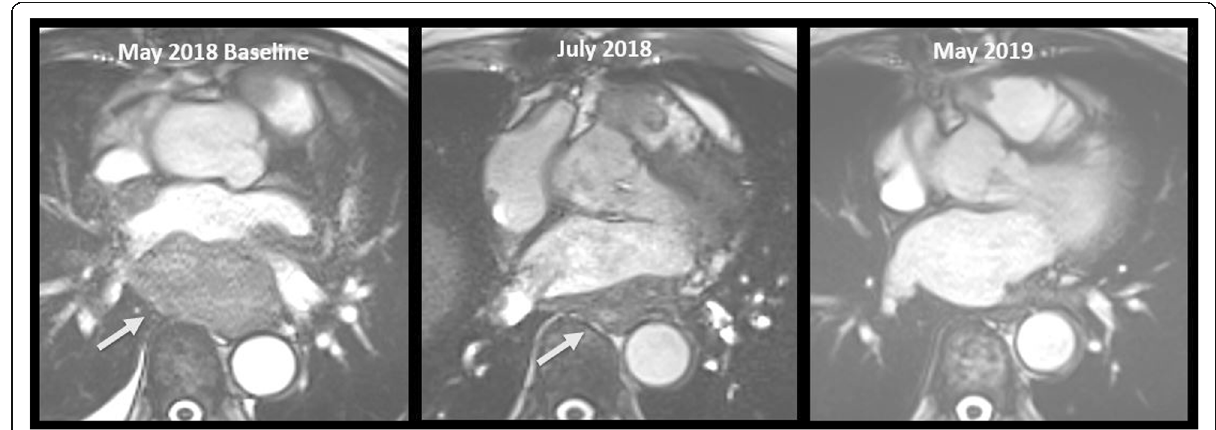
Fig. 8 A 75-year-old woman with a low-differentiated primary cardiac sarcoma with microsatellite instability, treated with pembrolizumab (anti- PD-1). Baseline contrast-enhanced MRI image shows a large retroatrial mass (arrow). Two months follow-up (FU) imaging shows a good reduction in the size of the mass assessed as -34% according to iRECIST criteria (partial response, arrow). One year FU imaging shows a complete